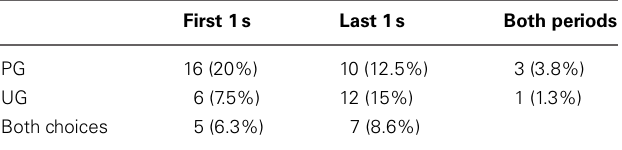
Table 1 | Distribution of units signaling the previous and upcoming goal choices.